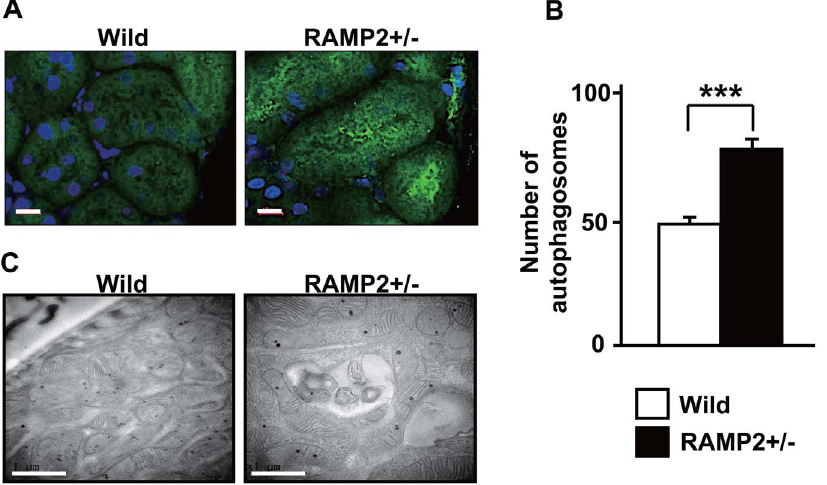
Figure 5. STZ enhances tubule cell autophagy in RAMP2 + / 2 kidneys. (A) Fluorescent immunostaining of LC3 (green) and DAPI (blue) in proximal renal tubules 4 weeks after STZ administration to wild-type and RAMP2 + / 2 mice. (B) Comparison of autophagosome numbers between wild-type and RAMP2 + / 2 kidneys. Numbers of LC3-positve particles per microscope field were counted in LC3 immunostained sections. A total of 10 fields were analyzed. (C) Electron micrograph showing autophagosomes in a renal tubule cell. Bars are means 6 SEM. ***p , 0.001. Scale bars=10 m m (A), 1 m m (C).